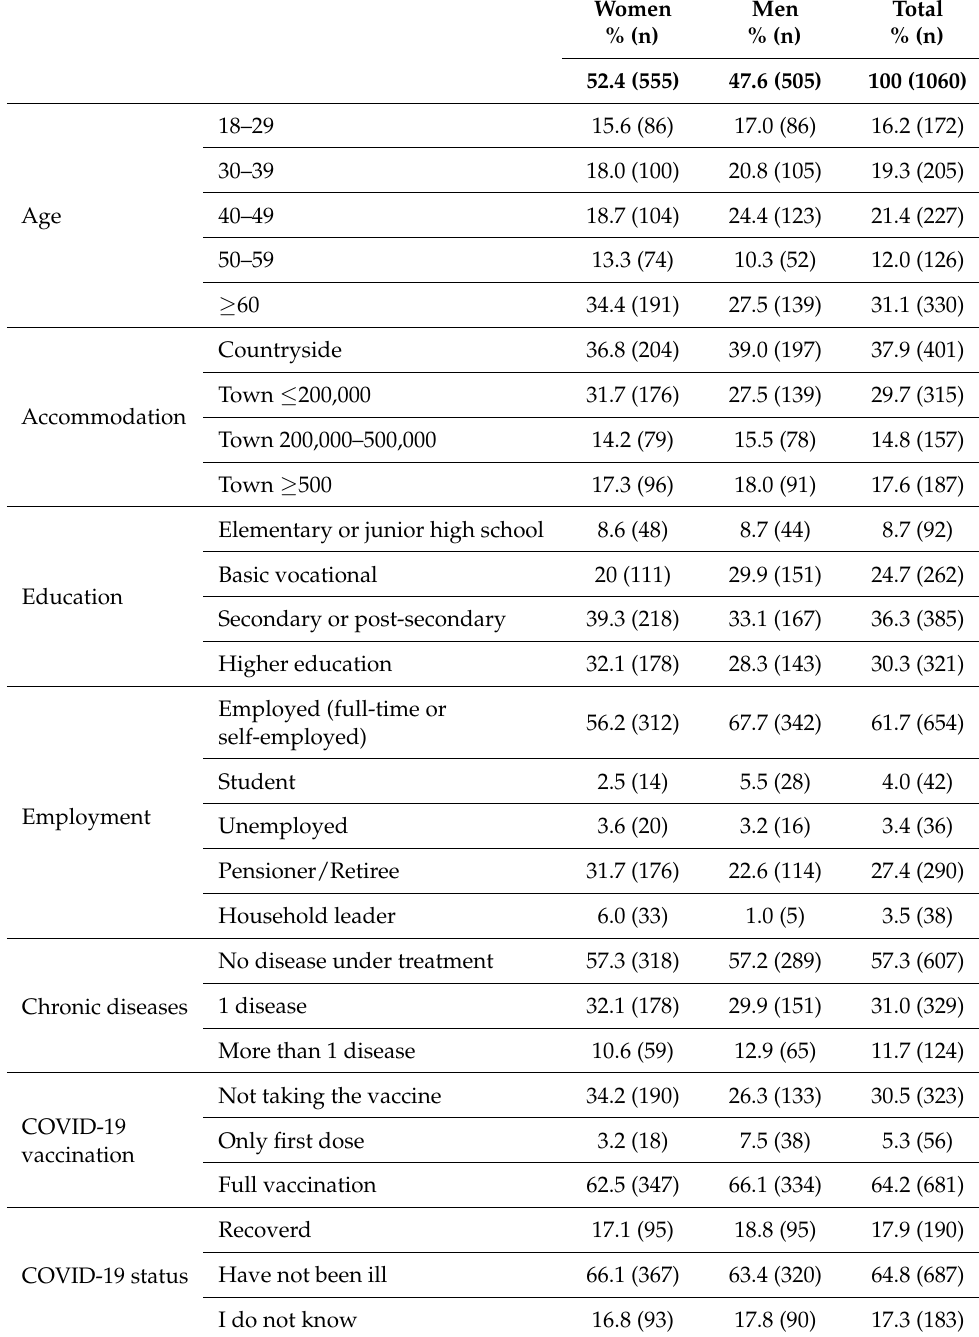
Table 1. Characteristics of the